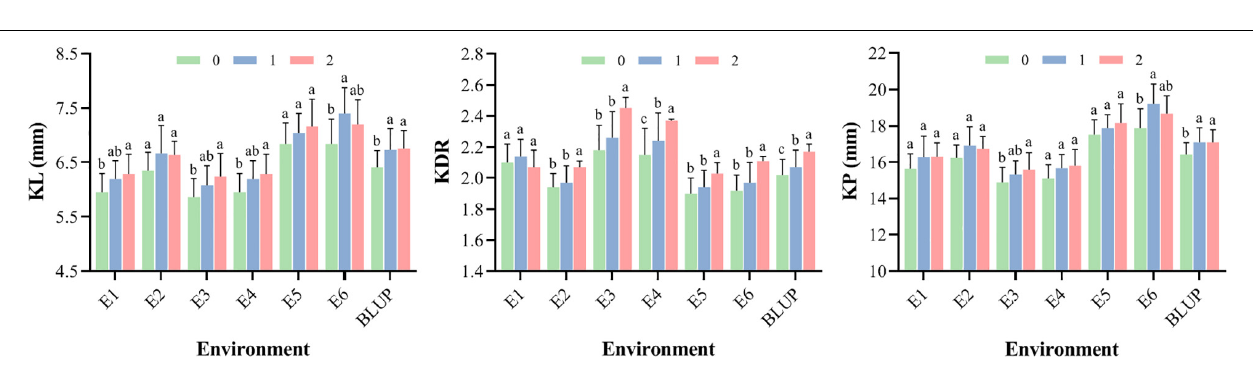
FIGURE 5 | Box plot for phenotypic values of two allelic groups belonging to the associated markers identified under BLUP environments. The significant difference between the phenotype of two allelic groups was analyzed by T -test ( ∗∗ P ≤ 0.01; ∗∗∗ P ≤ 0.001; ∗∗∗∗ P ≤ 0.0001). The X-axis shows the two alleles for each SNP marker, and the Y-axis shows the phenotypic values of kernel traits.